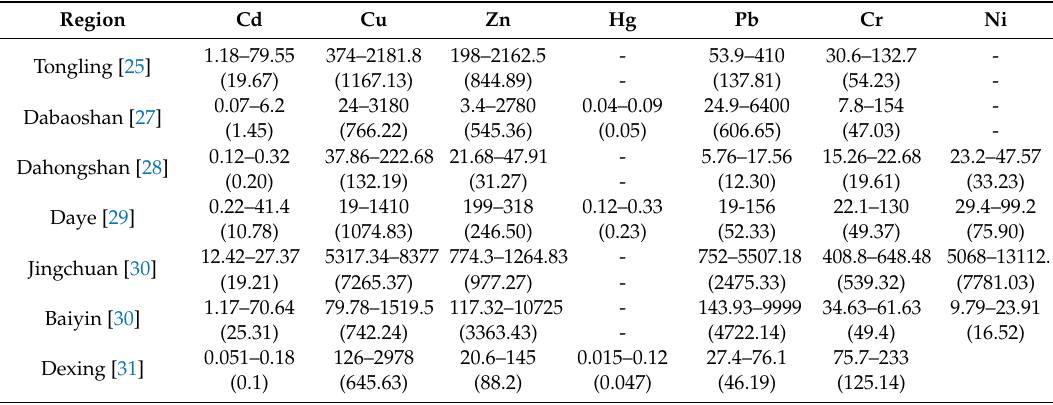
Table 3. Distribution characteristics of heavy metal concentration in sediments of typical copper deposits in surrounding rivers (mg /